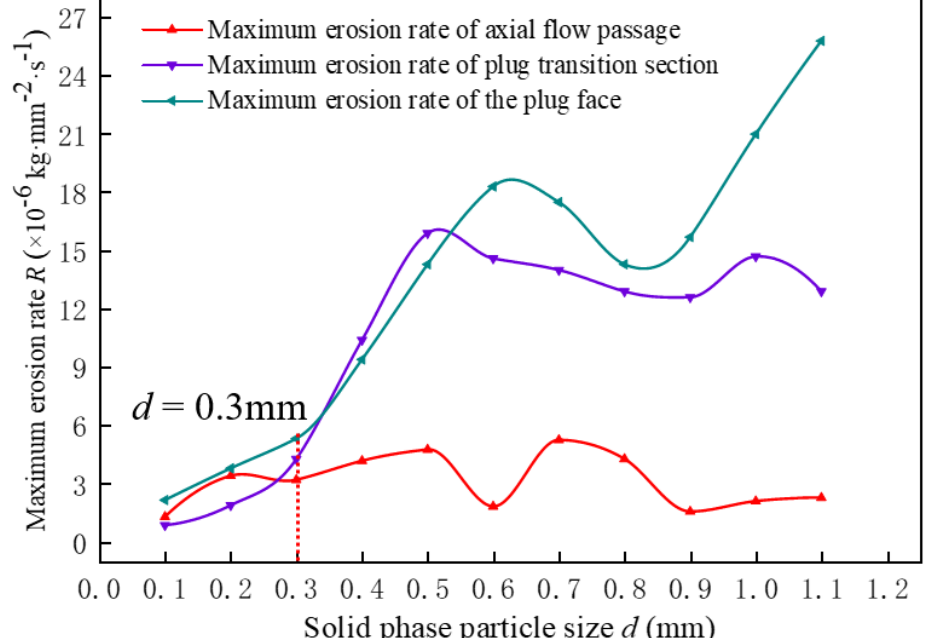
Figure 9. The maximum erosion rate changes with solid particle diameter.